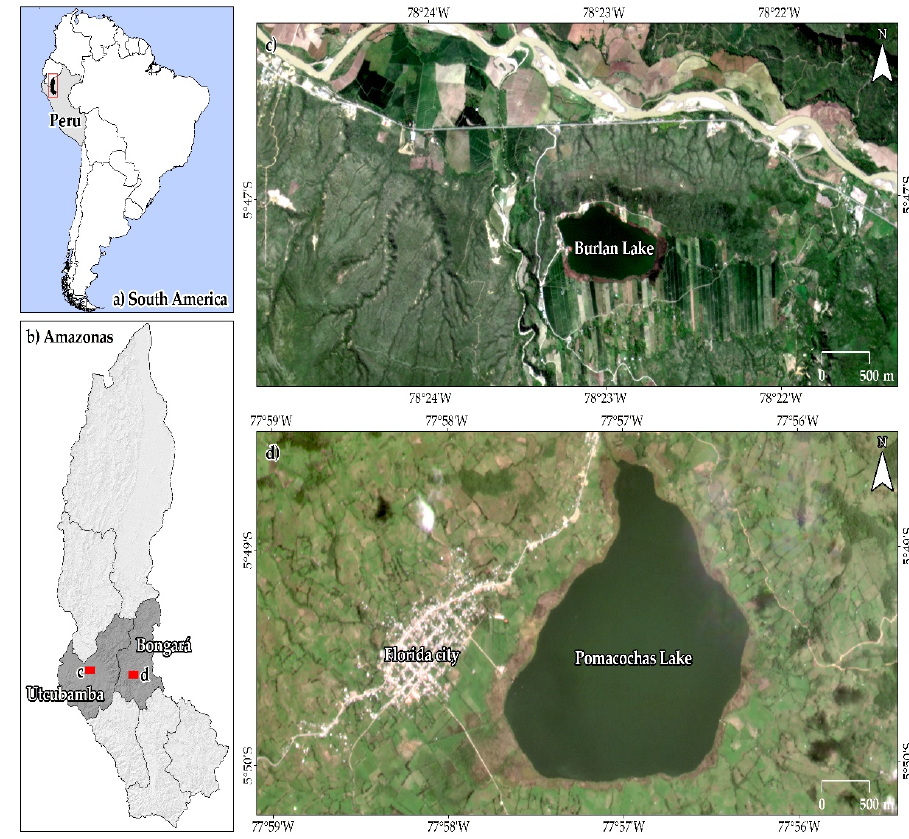
Figure 1. Geographic location of the study lakes in NW